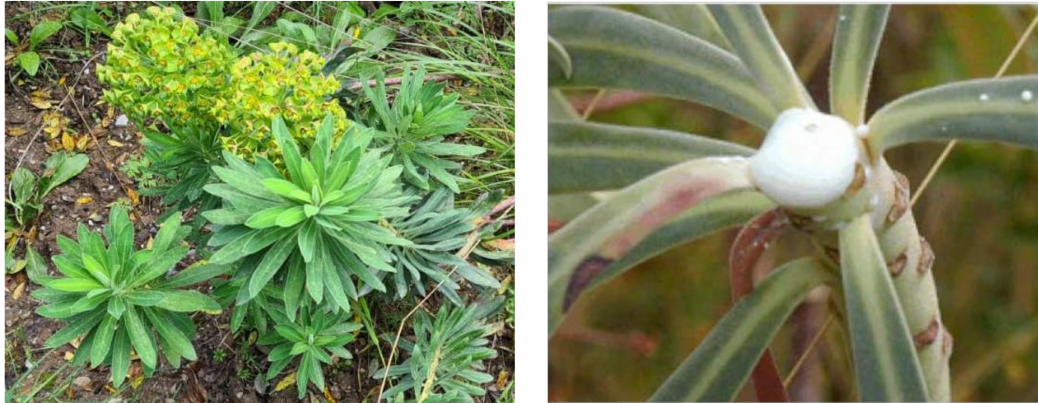
Figure 1. The Mediterranean shrub E. characias. Leaves and characteristic flowers are visible in the imagine on the left ( a ), while ( b ) clearly shows the milky latex that exudes from the cut branch of the plant (imagine modified from reference